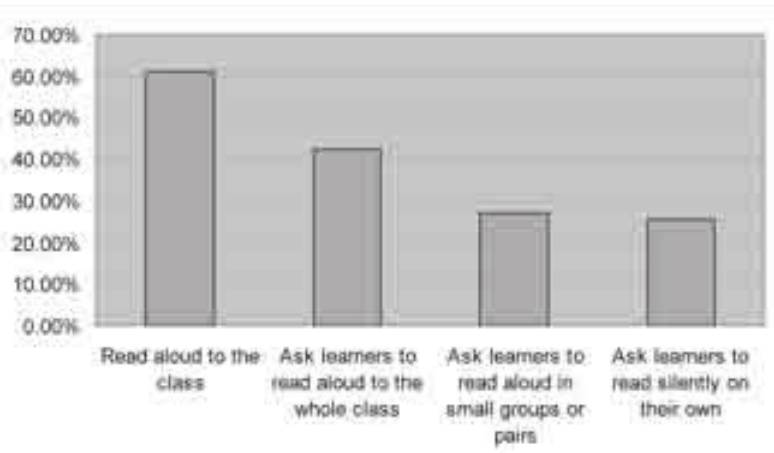
Figure 3: Teacher engagement in everyday reading